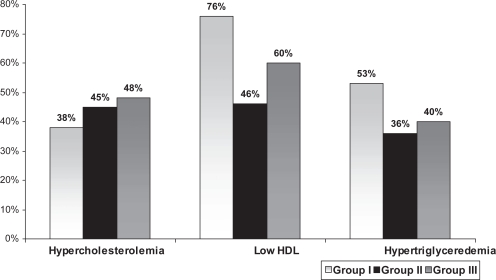
Comparison of dyslipidemia between different age groups (P < 0.01).